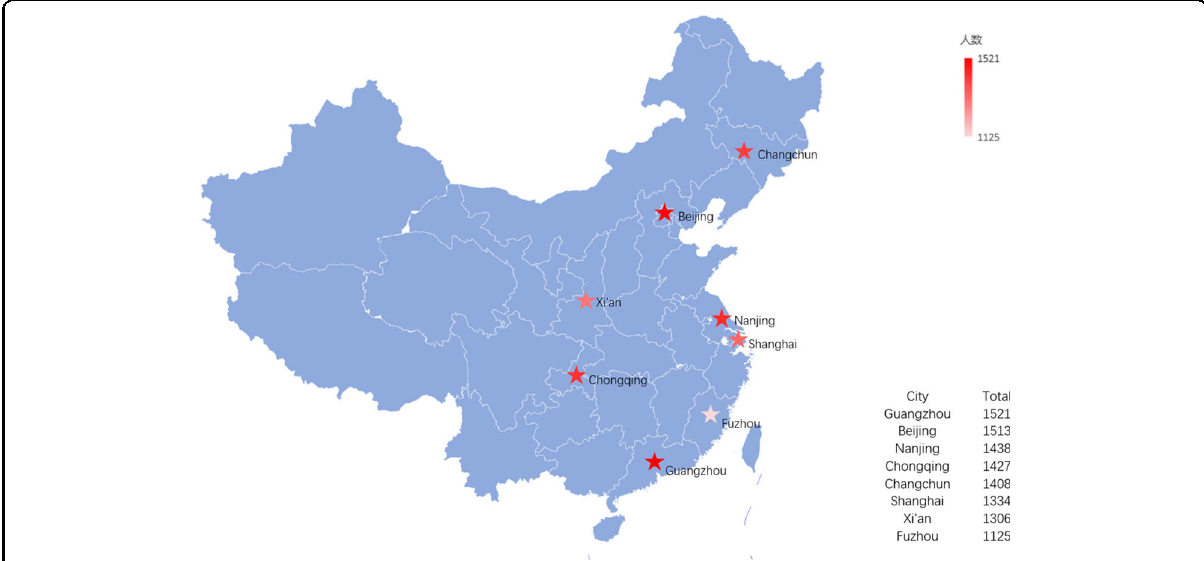
Fig. 2 Sampling distributions. The 8 cities in the North (Beijing, Changchun), East (Shanghai, Nanjing), West (Chongqing, Xi ’ an) and South (Guangzhou, Fuzhou) regions of China fi nally enrolled and the valid number in each